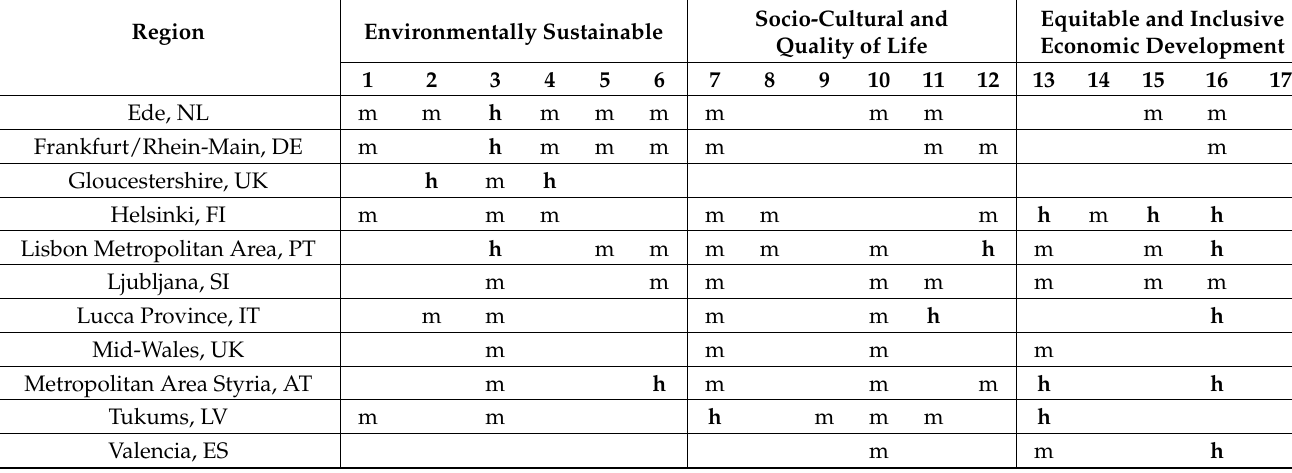
Table 3. Summary overview on how important specific sustainable wellbeing aspects are for each region. (‘ h ’ = high; ‘m’ = moderate; empty cells denote that a criterion does not stand out). Region Environmentally